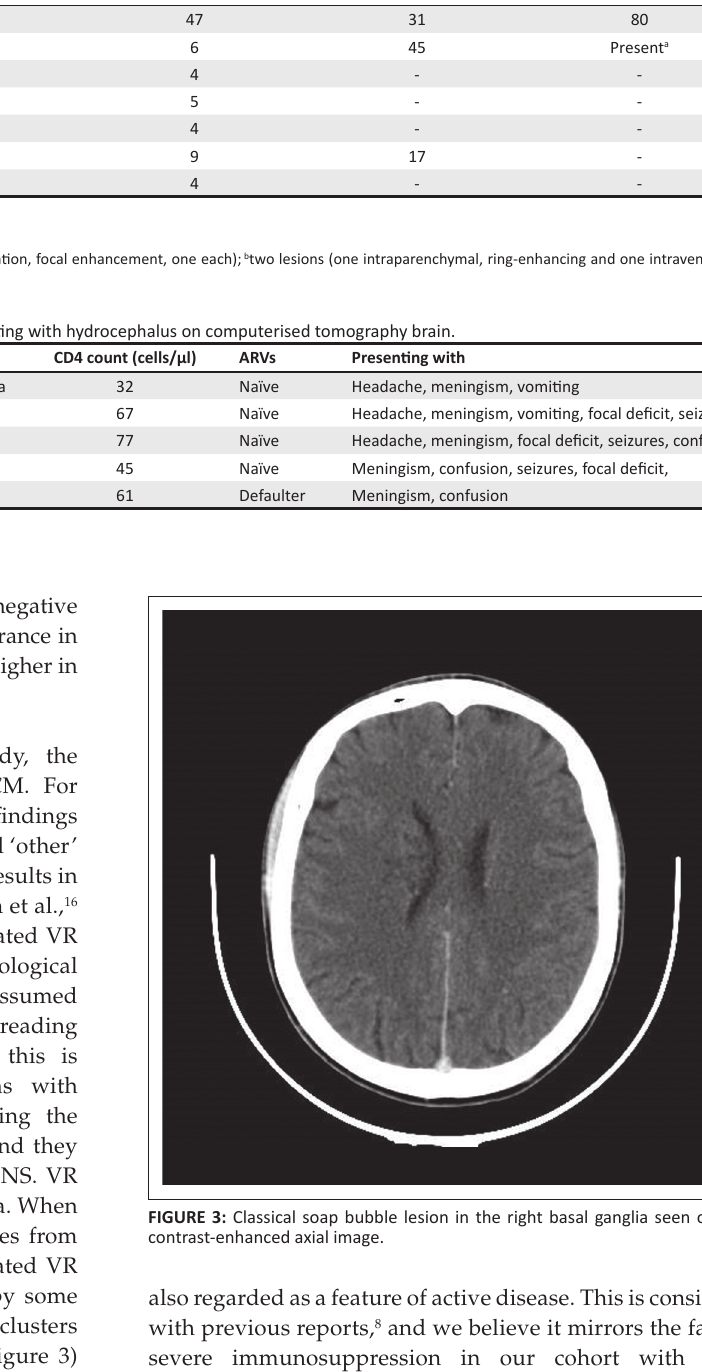
TABLE 2: Comparison of abnormal findings on computerised tomography brain imaging in HIV-associated neurocryptococcosis with other similar studies (in % ). Findings in % Present study ( n =